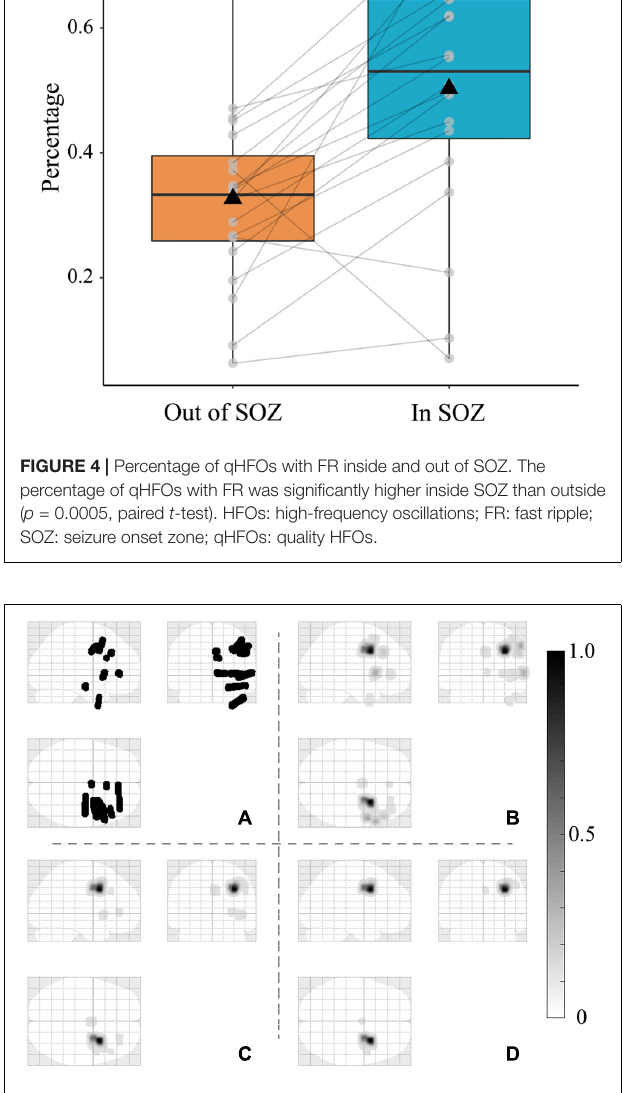
FIGURE 5 | HFOs imaging plotted on a glass brain in Montreal Neurological Institute space showing (A) the automatic labeled gray matter depth electrode coverage; (B) the spatial distribution of cHFOs; (C) the distribution of qHFOs and the spatial distribution of qHFOs with FR (D) . It can be seen from the figures that with classification, the result was more specific and localized, indicating SOZ. No thresholding was used in the above figures. The intensity bar represents the min-max normalized HFOs occurrence rates. HFOs: high frequency oscillations; cHFO: candidate HFOs; qHFO: quality HFOs; FR: fast ripple; SOZ: seizure onset